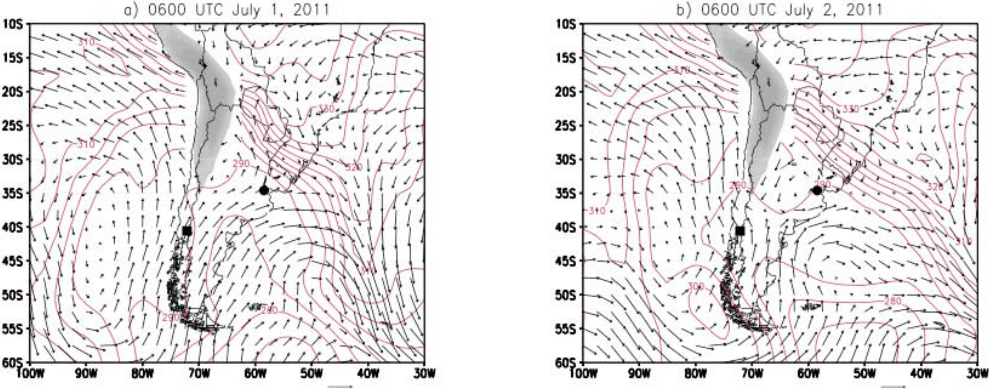
Fig. 3. 850hPa horizontal wind (in ms − 1 , vectors) and equivalent adiabatic potential temperature (in K, contours) for 06:00UTC on (a) 1 July 2011 and (b) 2 July 2011. The square indicates the location of the Puyehue volcano and the dot corresponds to the location of Buenos Aires. Terrain elevations greater than 1500m are